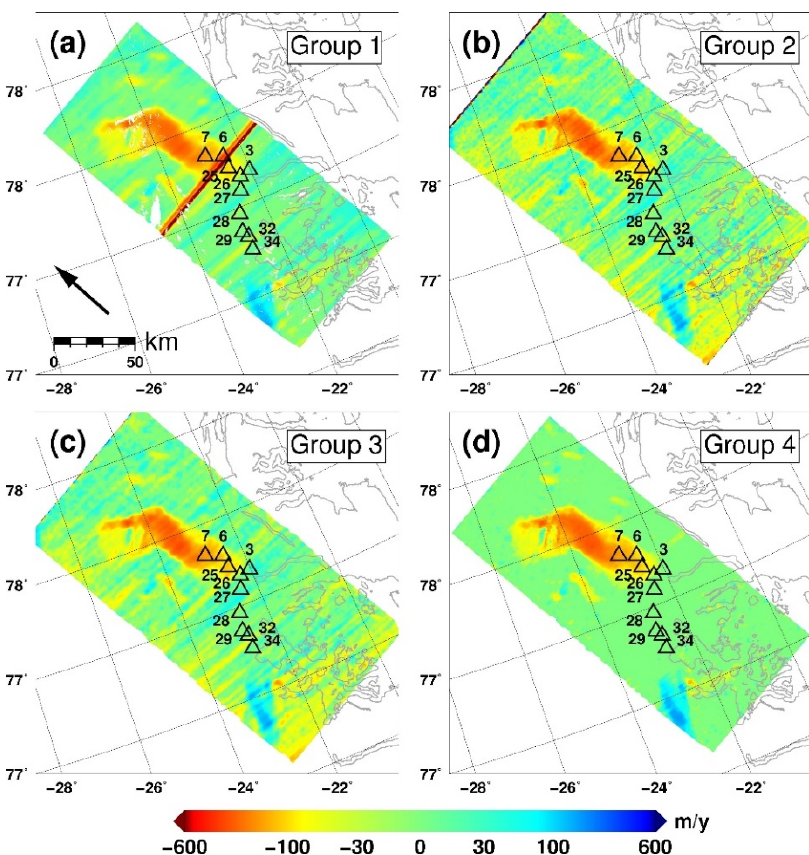
Figure 6. Task 2 azimuth velocity maps provided by groups 1 to 4 ( a – d ). Positive values correspond to motion along the satellite flight path, the ground projection of which is shown with an arrow in ( a ). The triangles represent the GPS stations used for validation.